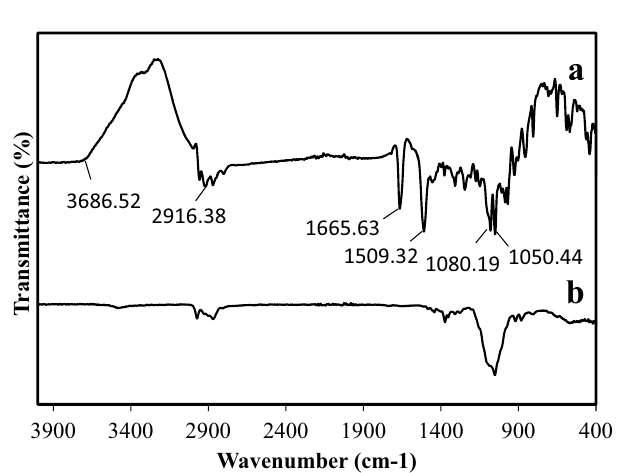
Figure 5. FTIR spectra of ( a ) pure CLN-free base, ( b ) C6